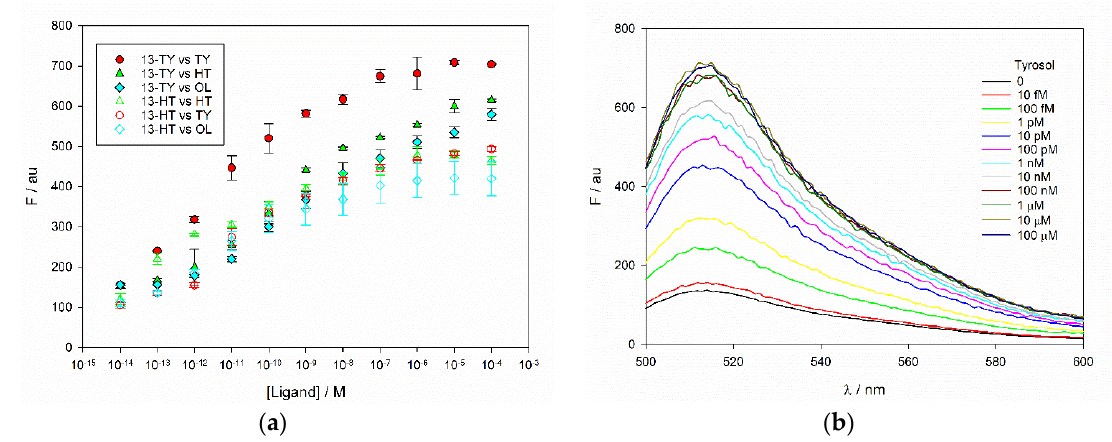
Figure 6. ( a ) fluorescence emission of MIPs 13-TY and 13-HT upon increasing concentrations of TY, HT and OL. ( b ) emission spectra of MIP 13-TY along the titration with TY.